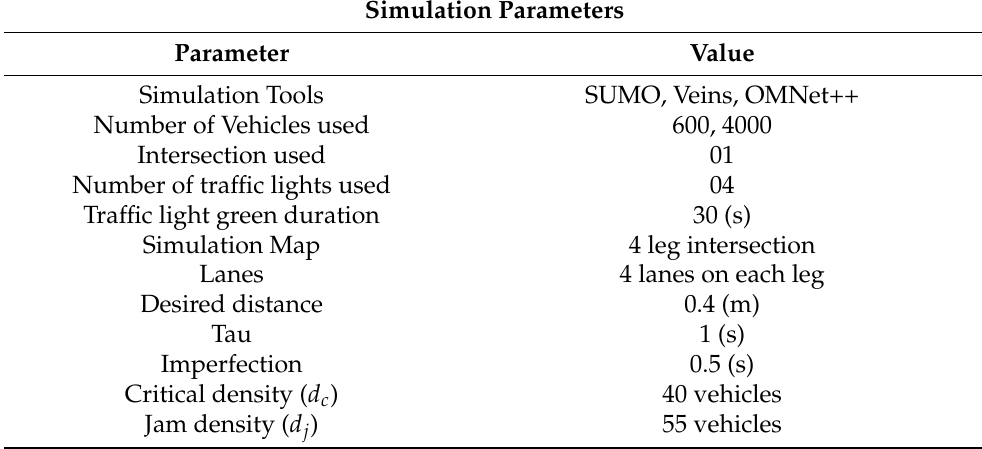
Table 1. Environment